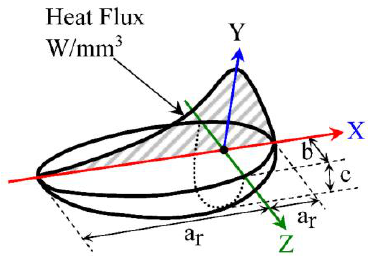
Fig. 4. Double ellipsoid heat